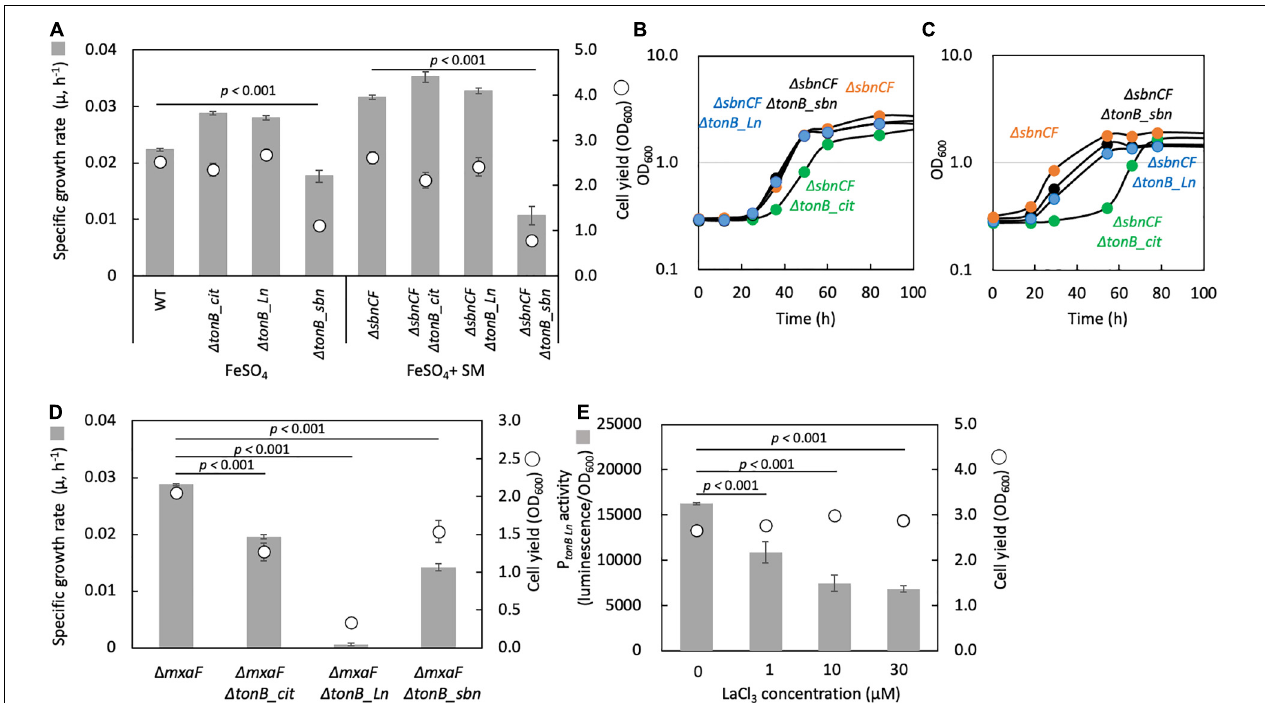
FIGURE 6 | (A) Growth of the mutants of each TBDR gene generated under the wild-type strain 22A (WT) and (cid:49) SbnCF backgrounds on succinate supplemented with 100 µ M FeSO 4 10% WT spent medium (SM), respectively. (B) Growth of the mutants of each TBDR gene generated under the background of (cid:49) sbnCF on succinate under 100 µ M iron citrate. (C) Same experiment as (B) but with 50 µ M citric acid and 50 µ M FeSO 4 . (D) Growth of the mutants of each TBDR gene generated under the (cid:49) mxaF background on methanol under 100 µ M iron citrate and 30 µ M LaCl 3 . (E) P tonB_Ln activity in WT grown on methanol in the presence of different concentrations of LaCl 3 . The gene disruption mutants were grown in the presence of kanamycin throughout the experiment. All data represent the mean of three replicates ± standard deviation (SD).